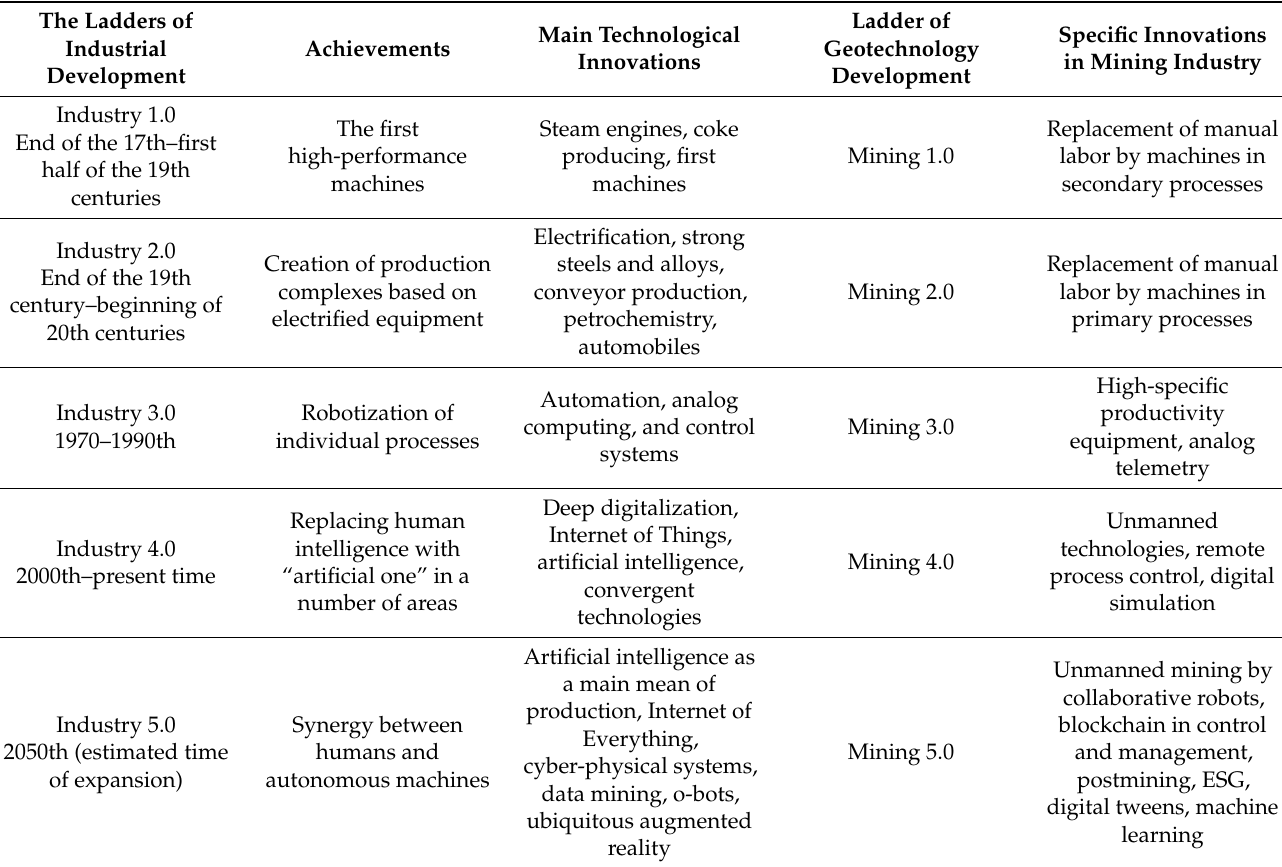
Table 1. Main technological innovations and achievements of Mining 5.0 (Adapted from Ref. [2]).